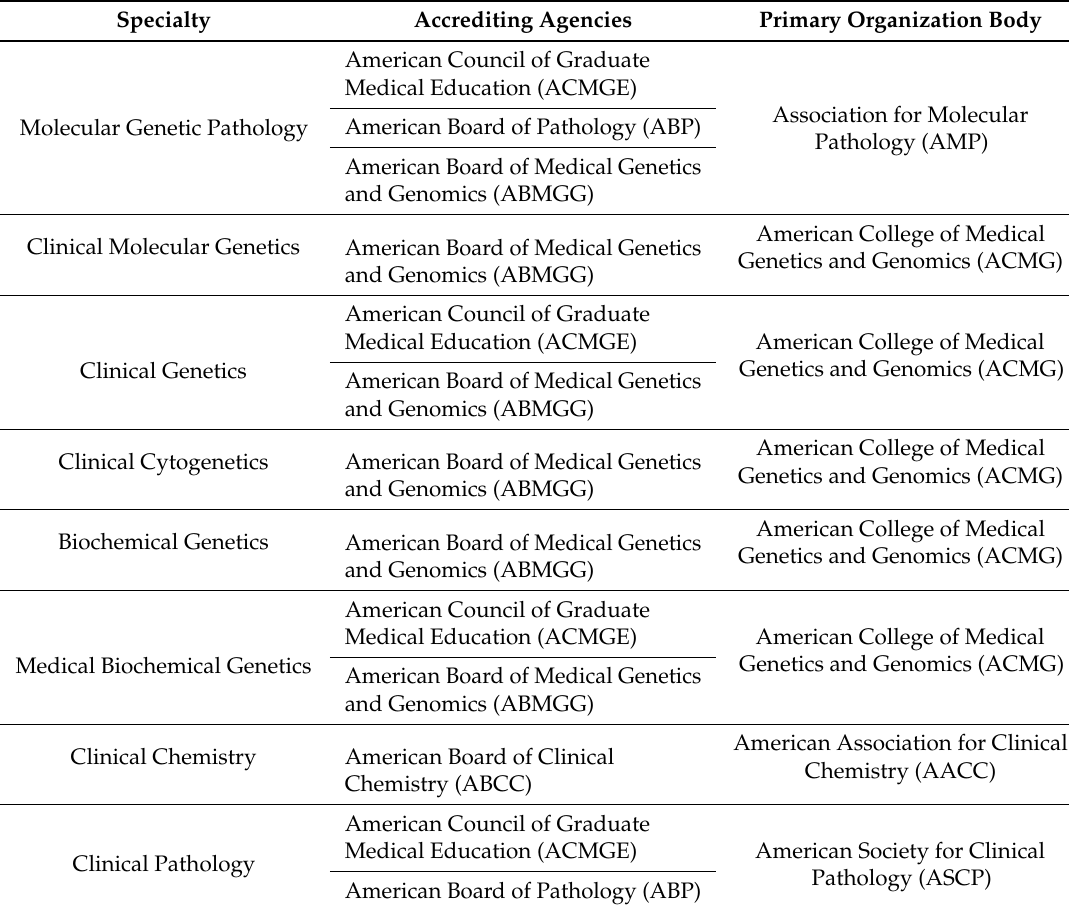
Table 1. Medical specialties with training in genomic